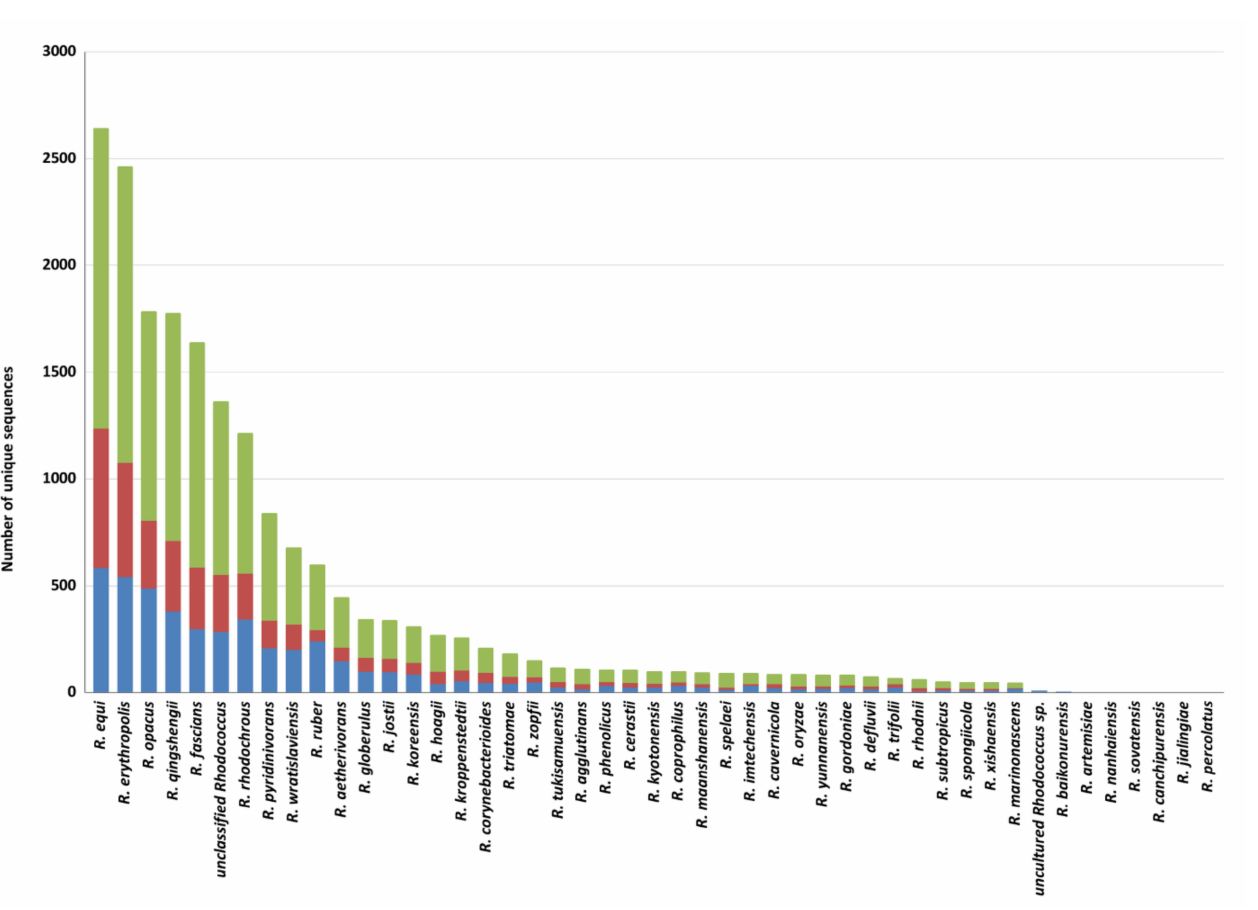
Figure 4. Total number of unique HIT sequences identified in Rhodococcus species genomes for each polymer category: polyesters, heteroatomic backbone plastics, and C − C backbone